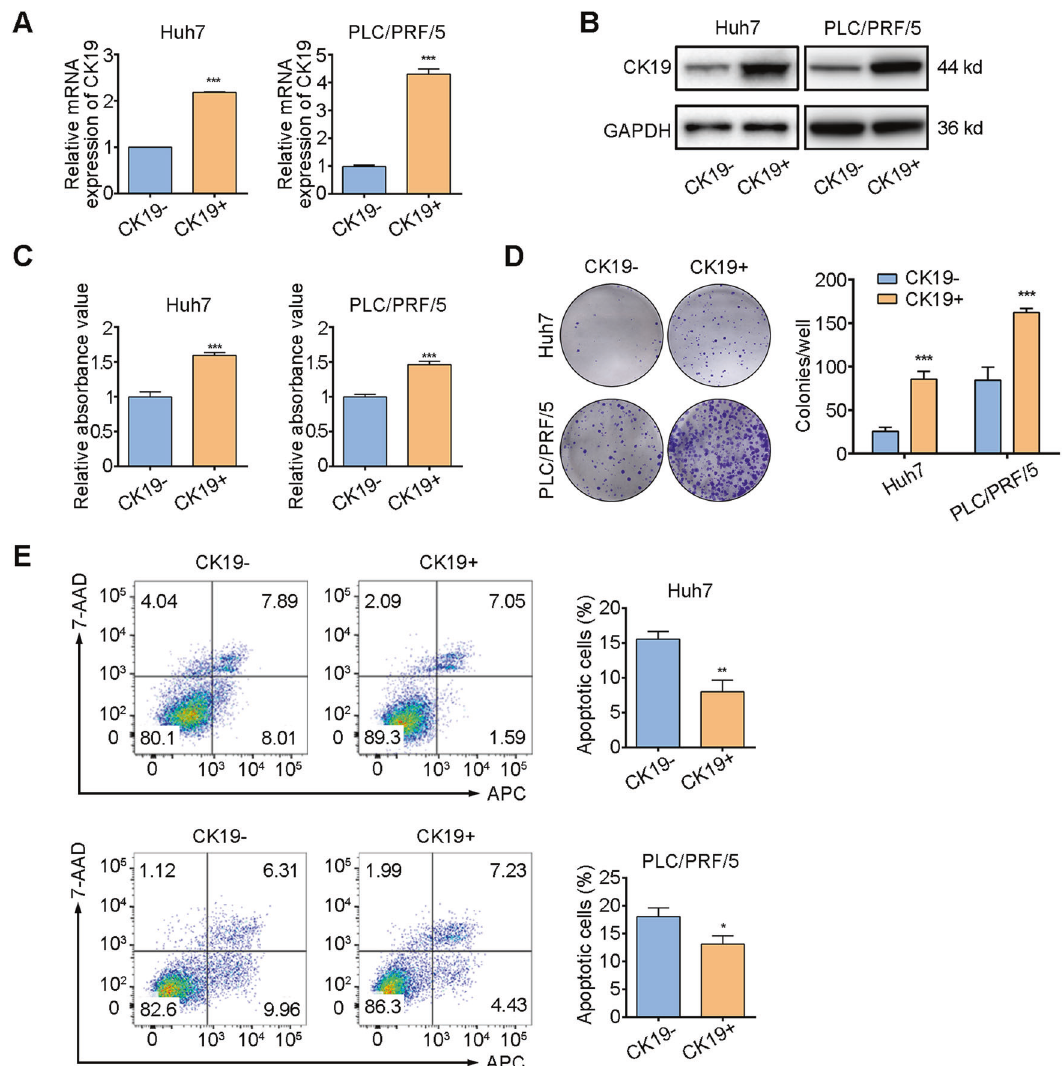
Fig. 2 Phenotype validation after construction of a CK19 promoter report system. A qPCR and B immunoblotting detection in CK19 − and CK19 + HCC of Huh7 and PLC/PRF/5 cells. C CCK-8 assay, D colonial formation, and E cell apoptosis assay in CK19 − and CK19 + of Huh7 and PLC/PRF/5 cells. The data are shown as mean ± SD. * P < 0.05, ** P < 0.01, and *** P < 0.001. CCK-8, cell counting kit-8; HCC, hepatocellular carcinoma; CK19 − , CK19-negative; CK19 + ,